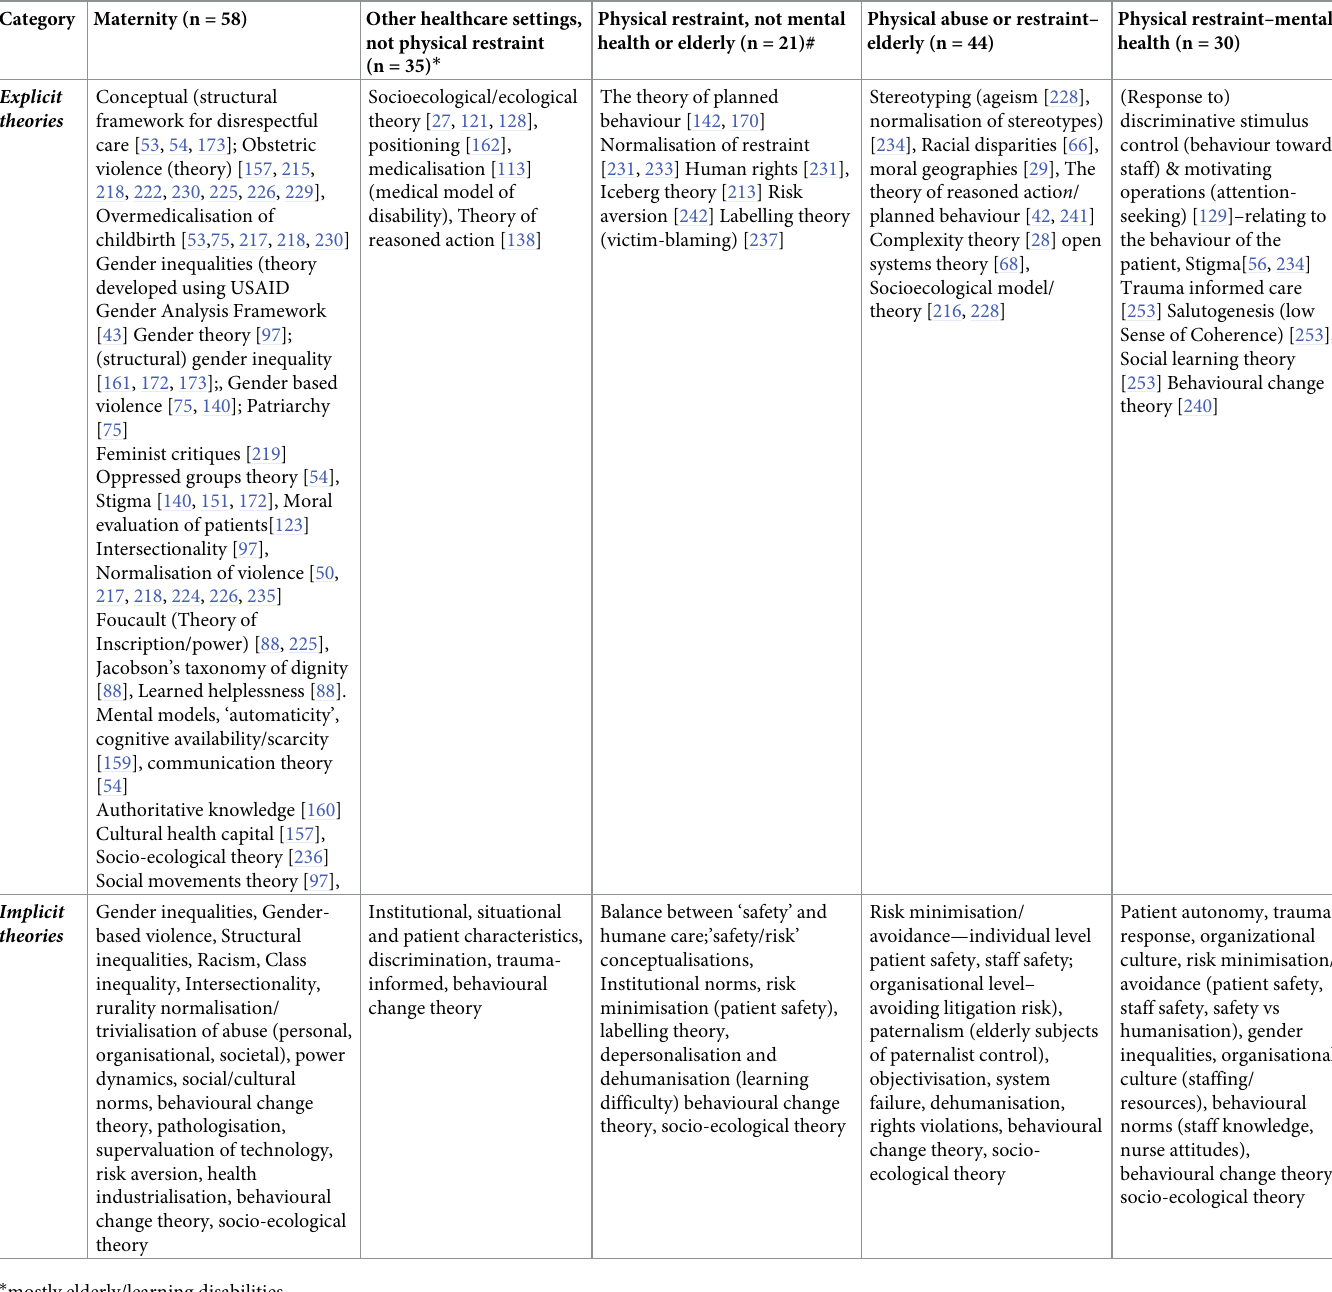
Table 2. Examples of explicit or implicit theories in included papers, by mistreatment type/ setting. Category Maternity (n =